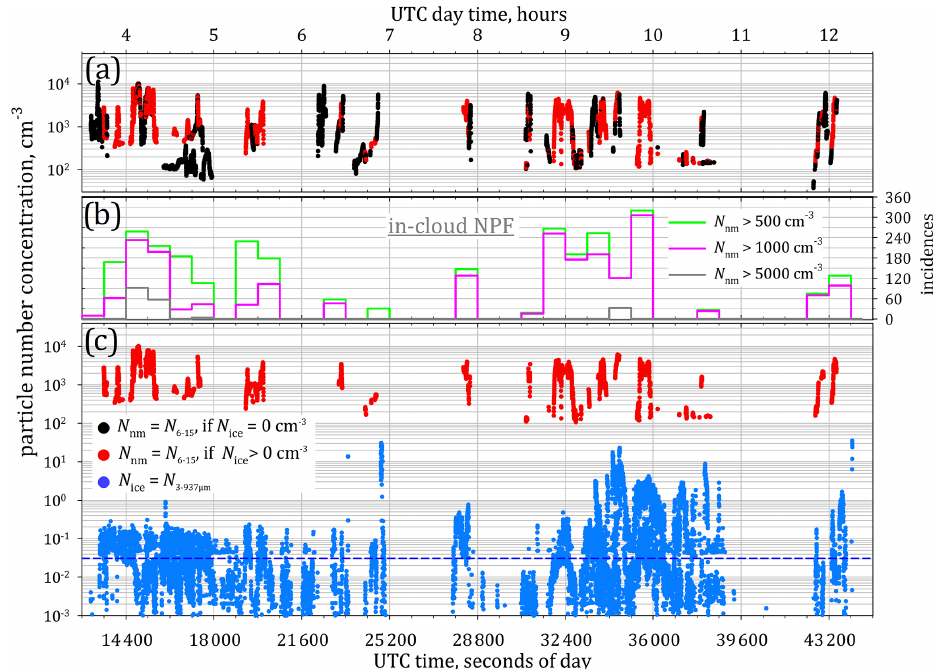
Figure 2. Number concentrations (1Hz resolved) of aerosol particles in the nucleation-mode size range ( N nm ) and of cloud (ice) particles ( N ice ) of the eight StratoClim flights compiled in one time series ranging from 03:30 to 12:30UTC. Kathmandu’s (Nepal) local noontime is indicated by the vertical orange line (corresponding to 06:15UTC, or 22500s of the day; UTC). (b) Incidences of concentrations N nm exceeding 500, 1000, and 5000cm − 3 within 15min time intervals. Data points of N nm in black whenever N ice (cyan) equals zero; other- wise N nm is coloured in red. The dashed blue line (c) indicates the median of N ice (0.031cm − 3 ) over all cloud particle detections during StratoClim 2017 (Krämer et al., 2020).